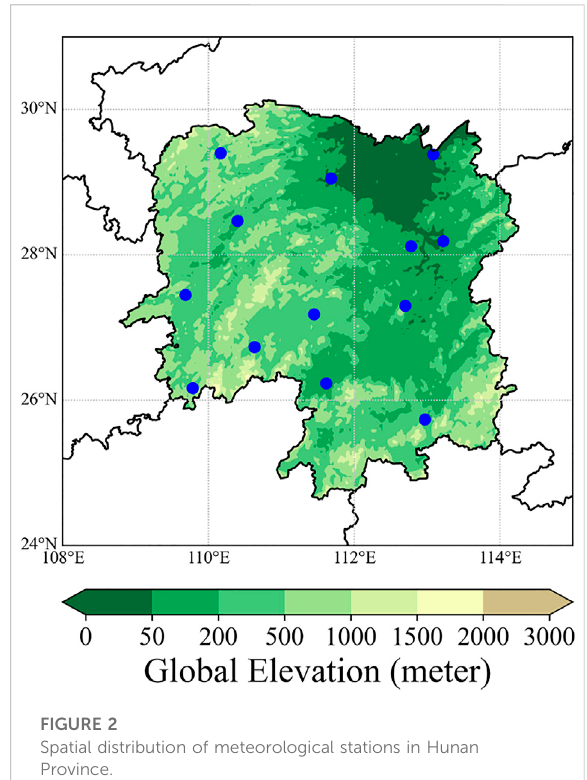
FIGURE 2 Spatial distribution of meteorological stations in Hunan